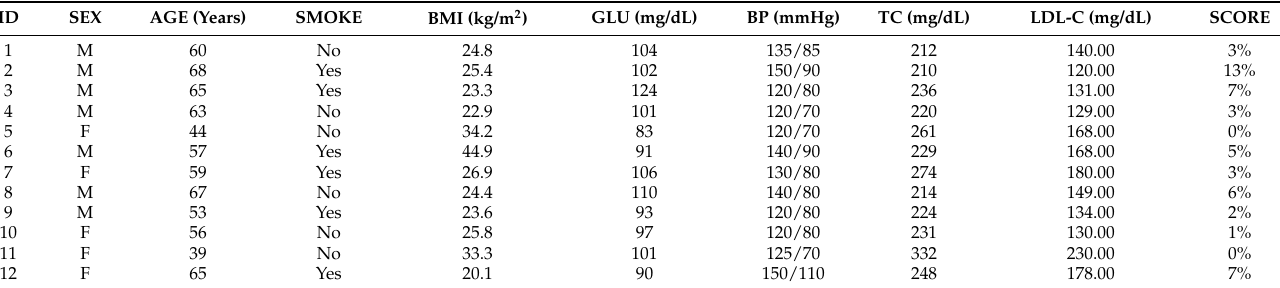
Table 1. Baseline characteristics of the analyzed